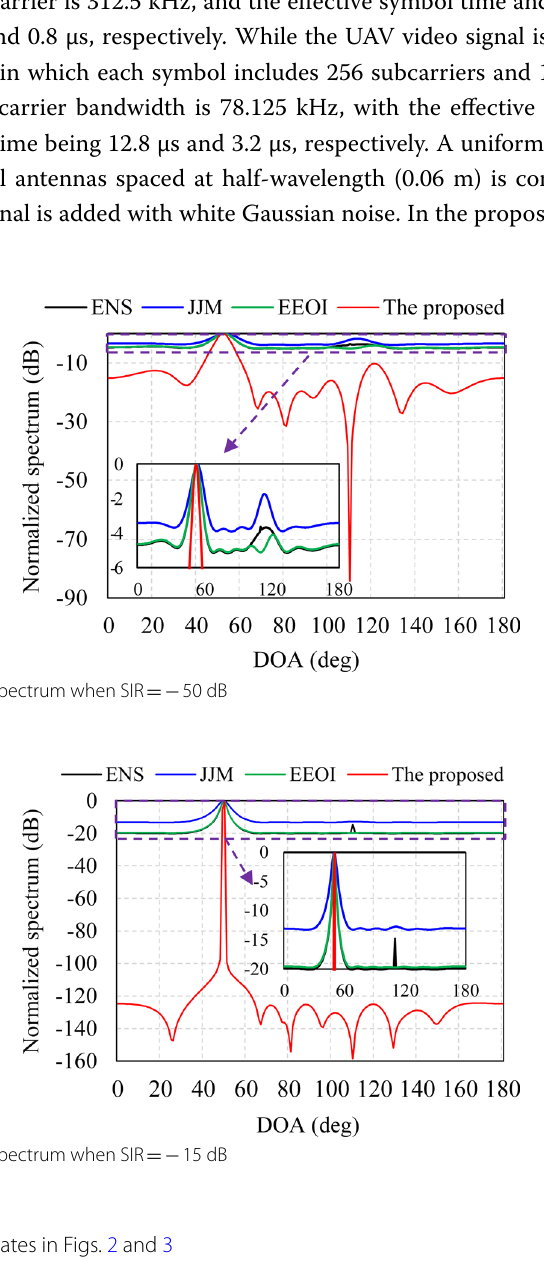
Fig. 4 Normalized spectrum when SIR